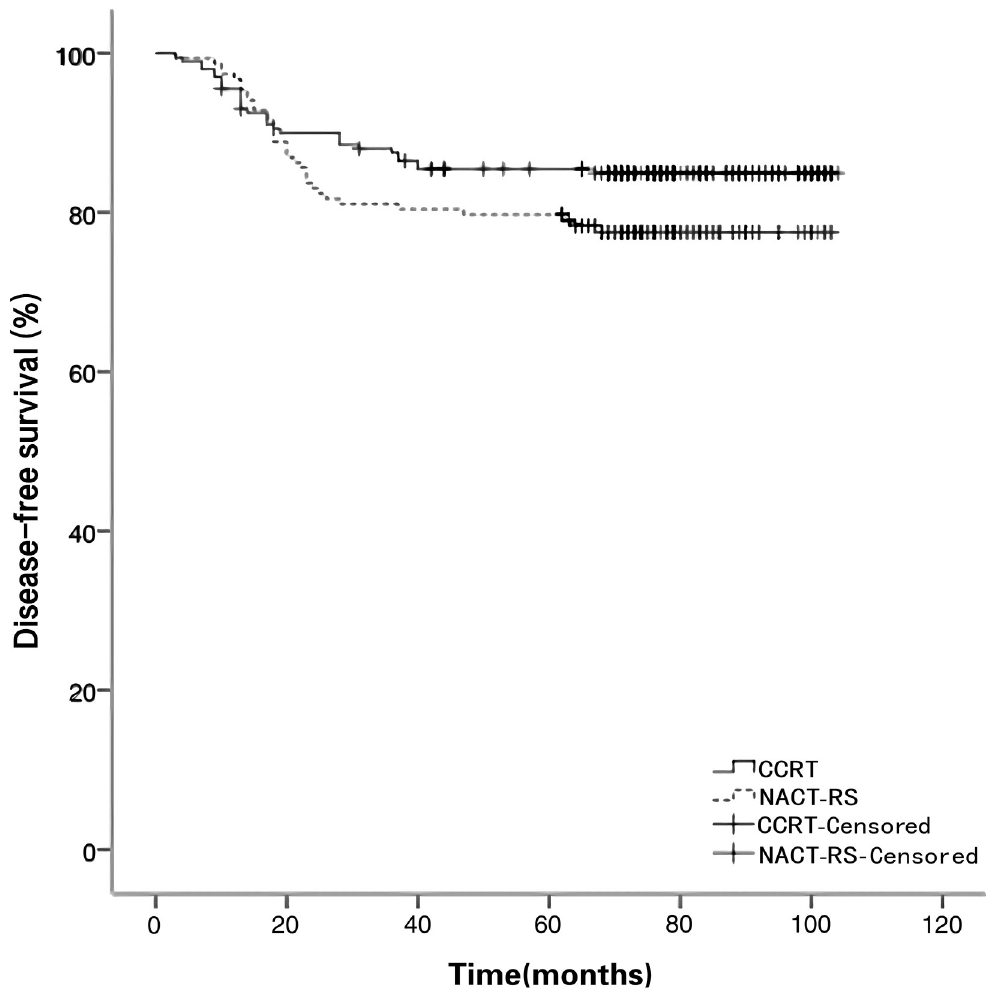
Fig 1. Disease-free survival curves for patients in the NACT-RS and CCRT groups. CCRT, concomitant chemotherapy, and radiotherapy; NACT-RS, neoadjuvant chemotherapy followed by radical